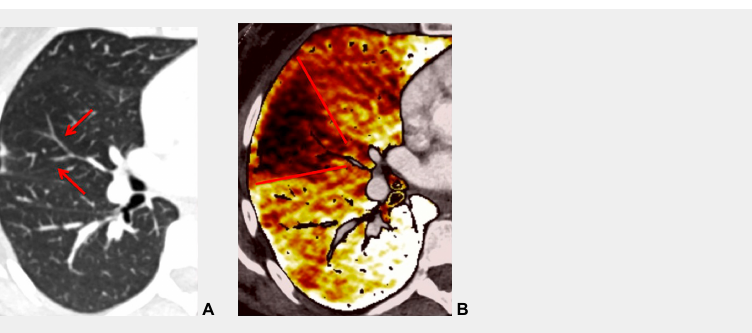
A Figure 4 Peripheral chronic thromboembolic pulmonary hypertension (CTEPH). No visible pulmonary artery emboli on standard CTPA are seen (arrows) ( A ) but a wide perfusion defect on the perfusion maps is depicted ( B ) and allows the diagnosis of peripheral